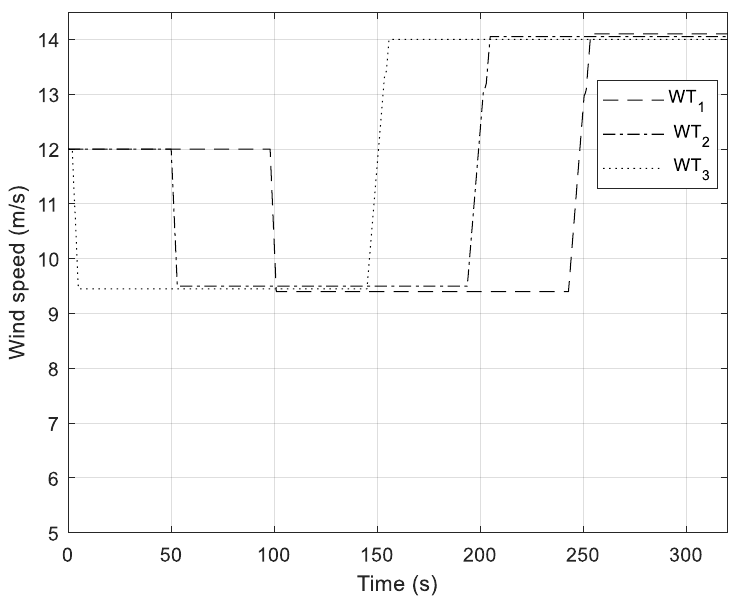
Figure 9. Wind profiles applied to the wind park.